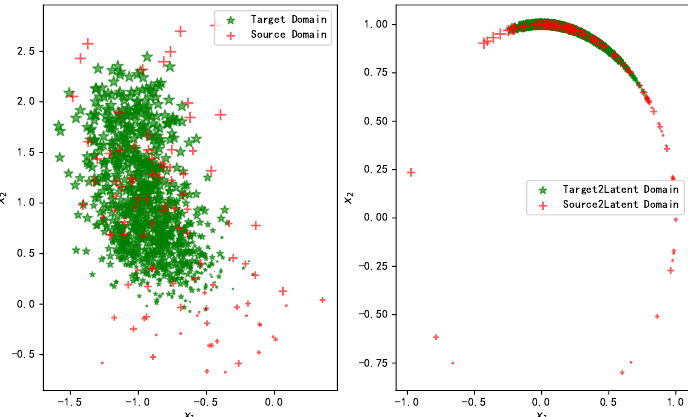
Figure 2. Fingerprint samples in source and target domains ( left ) after TCA transformation to the latent space ( right ).